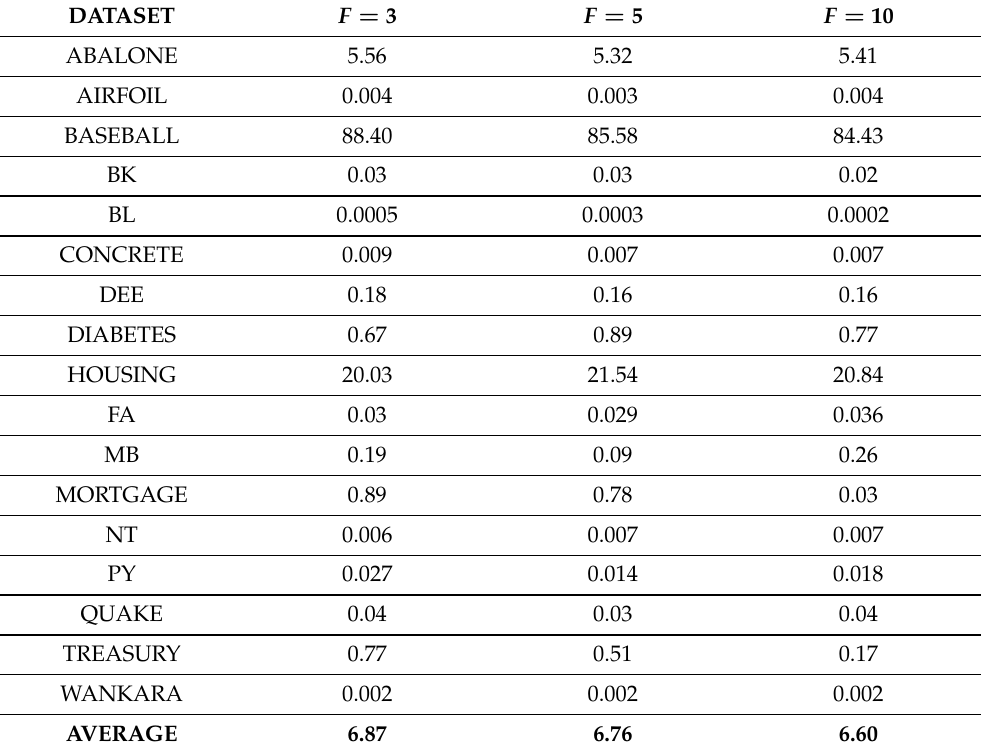
Table 5. Experimental results with the proposed method using different values for the parameter F on the classification datasets.